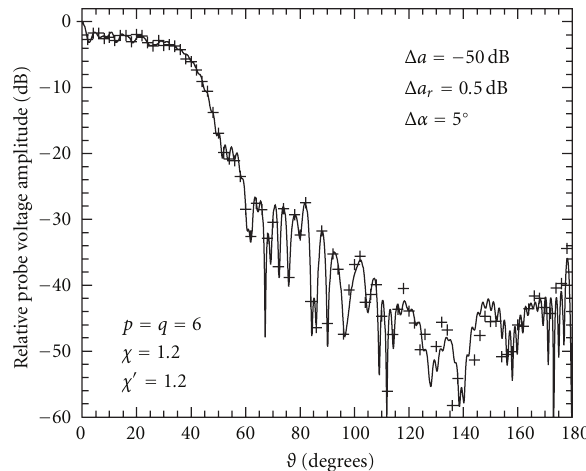
Figure 9: Amplitude of the output voltage V (cid:2) on the meridian at ϕ = 90 ◦ . Solid line: exact. Crosses: interpolated from error-a ff ected data.